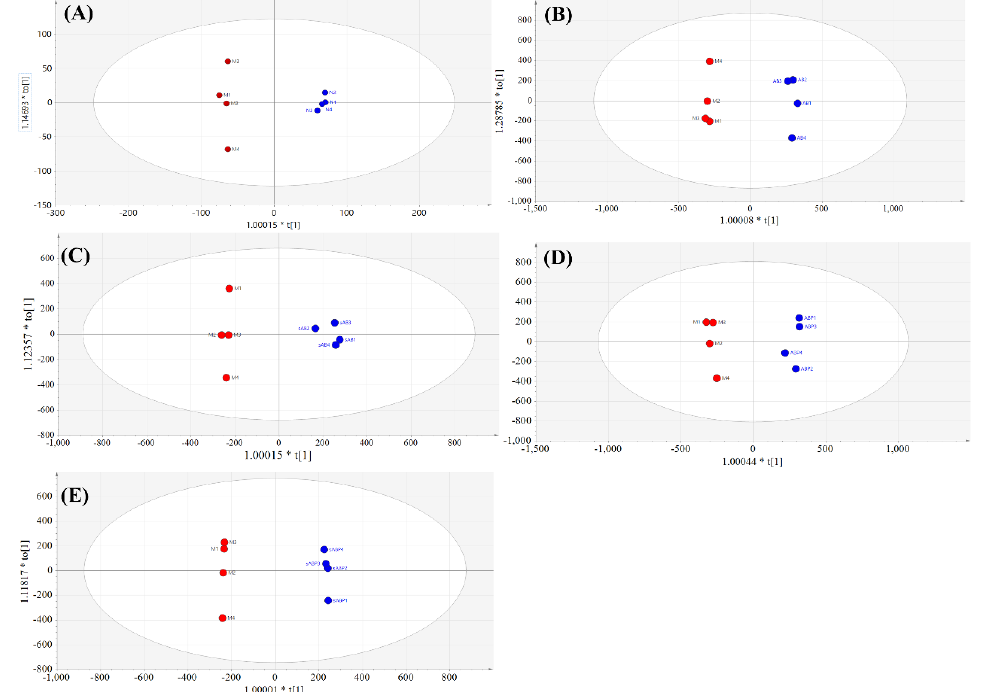
Figure 6. Score plots of OPLS-DA models: ( A ) model group vs. normal group, ( B ) model group vs. polysaccharide knockout component of crude AB, ( C ) model group vs. polysaccharide knockout component of salt-processed AB, ( D ) model group vs. polysaccharide component of crude AB, ( E ) model group vs. polysaccharide component of salt-processed